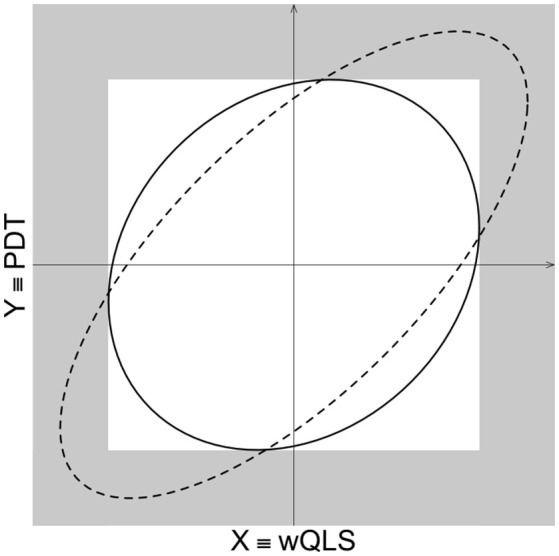
Comparison of rejection regions for POPFAM+, MAX, and a χ2 with 2 degrees of freedom. The rejection region of a POPFAM+ is outside the solid ellipse. The rejection region of χ2 test with 2 degrees of freedom is outside the dashed ellipse, and the rejection region of MAX, which is defined as max(X,Y), is shaded in gray.